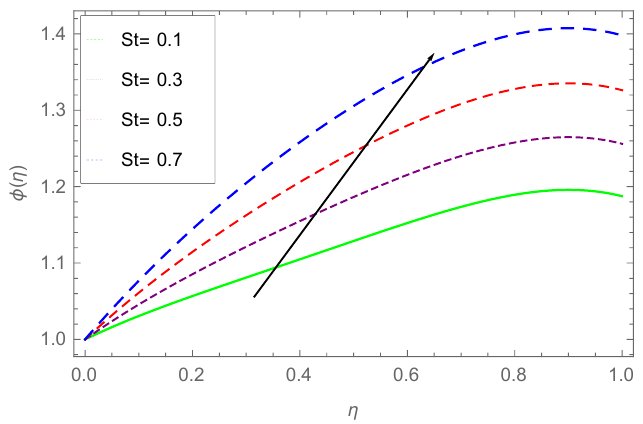
Figure 14. Impact of St on φ ( η ) , for Nt = 0.1, Nb = 1.2, Sc = 0.5, and β = 0.9.